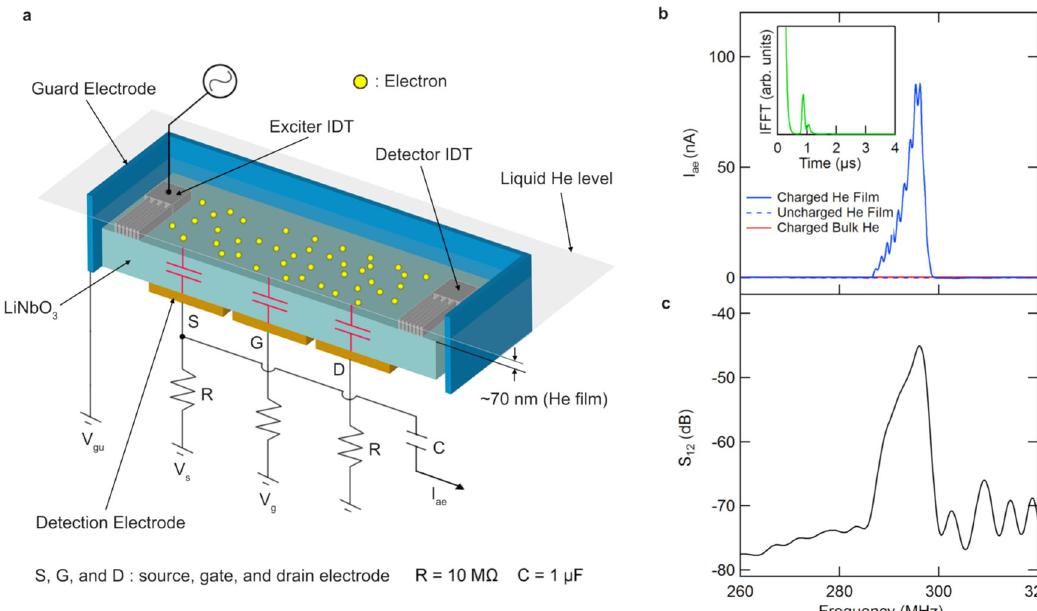
Fig. 1 Schematic of the experimental setup and demonstration of continuous wave acoustoelectric transport of electrons on helium. a Cross-section view of the device for measuring SAW-driven transport of electrons on helium. Two opposing interdigitated transducers (IDTs) are used to excite and receive SAWs. A saturated super fl uid 4 He fi lm is formed on the surface of the LiNbO 3 piezo-substrate at T = 1.55 K. Thermionically emitted electrons are trapped above the surface of the super fl uid fi lm by applying positive bias voltages to three underlying electrodes arranged in a fi eld-effect transistor (FET) con fi guration with a source (s), gate (g), and drain (d) 47 . Lateral con fi nement of the electron layer is achieved with a negative bias to the guard electrode positioned on the outside of the LiNbO 3 substrate. b Measured acoustoelectric current I ae of electrons on helium driven by a piezo-SAW as a function of frequency. For these measurements the FET electrode voltages were V s = V g = V d = 40 V, corresponding to an electron density of n ≅ 0.8 × 10 9 cm − 2 , and the guard was biased with − 3.2 V. Inset: inverse Fourier transform of the acoustoelectric current signal which reveals a peak at t ≈ 0.9 μ s. This time scale corresponds to a SAW propagation distance of 3.2 mm, roughly the same as twice the distance between the launching IDT center and the near-edge of the LiNbO 3 substrate, which implicates SAW re fl ections as responsible for the superimposed oscillations present on the acoustoelectric current peak. c Frequency dependence of the transmission coef fi cient ( S 12 ) of the SAW device demonstrating an expected resonance at 296